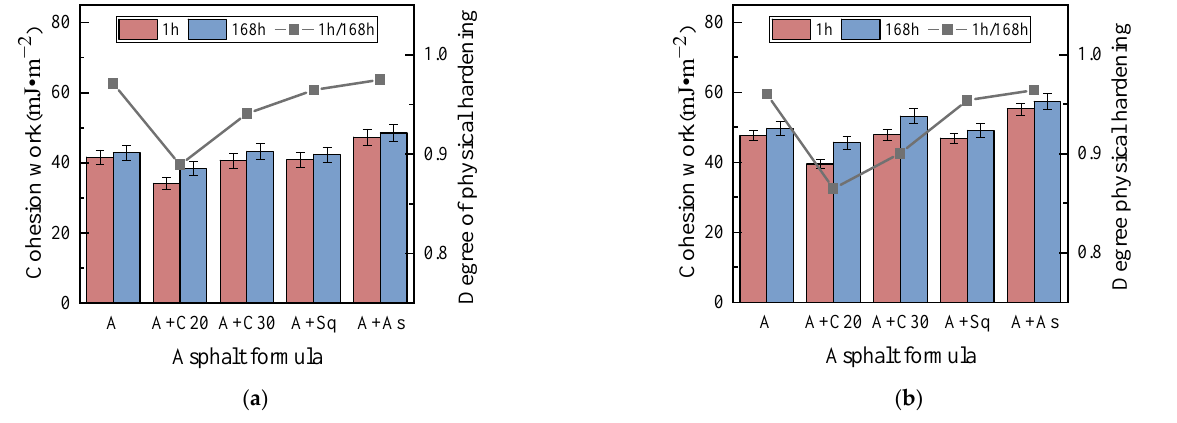
Figure 9. Cohesion work in dry conditions. ( a ) Asphalt A. ( b ) Asphalt B.